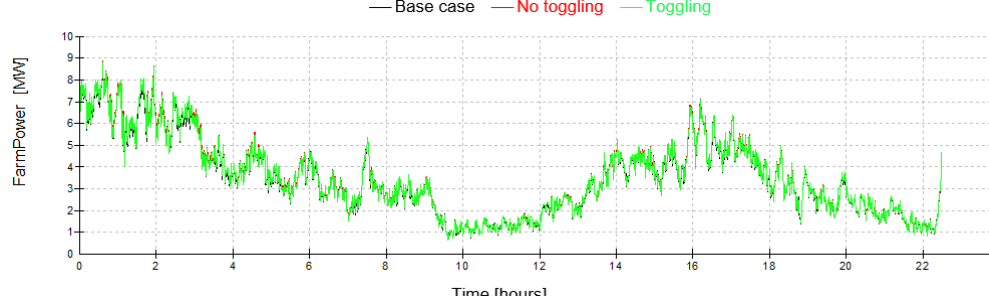
Figure 12. Total power output for the toggle test simulations.